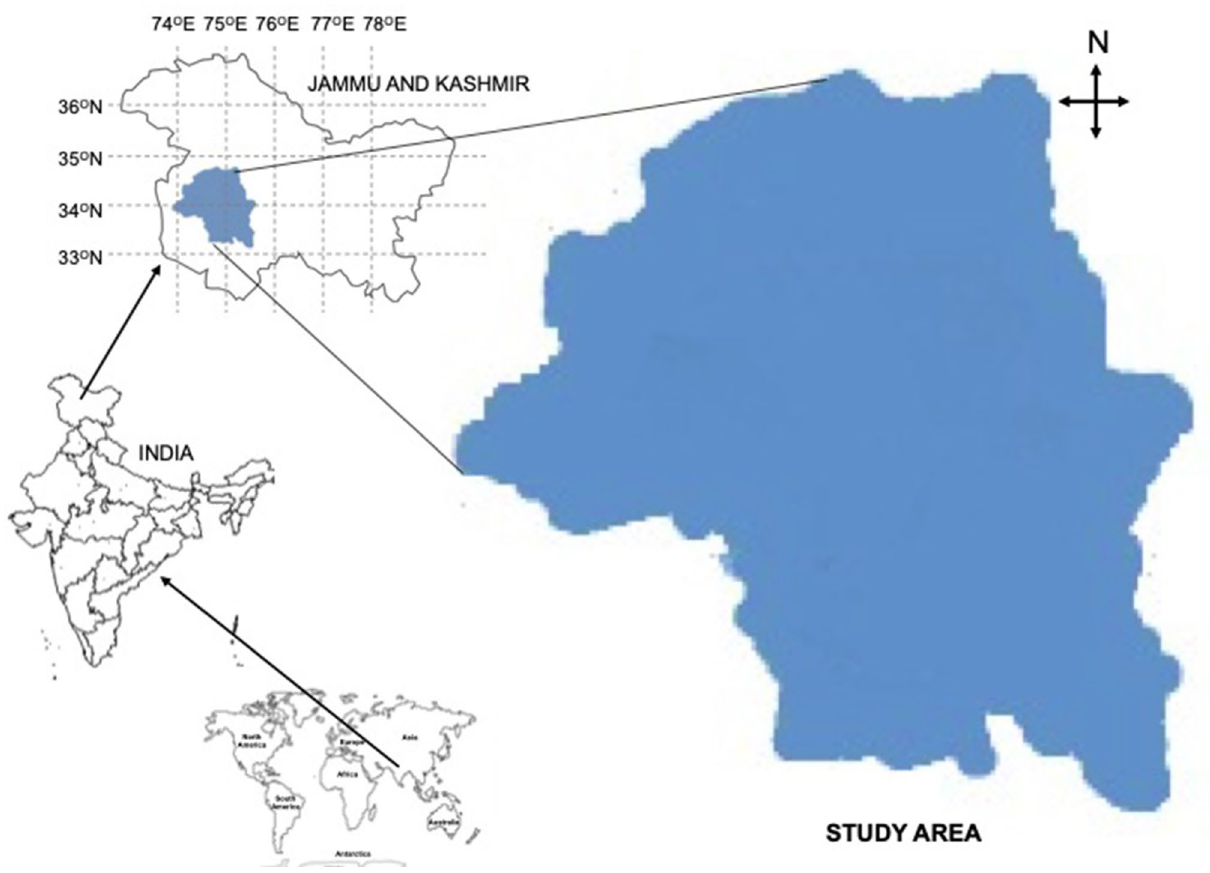
Figure 7. Location of the research/study